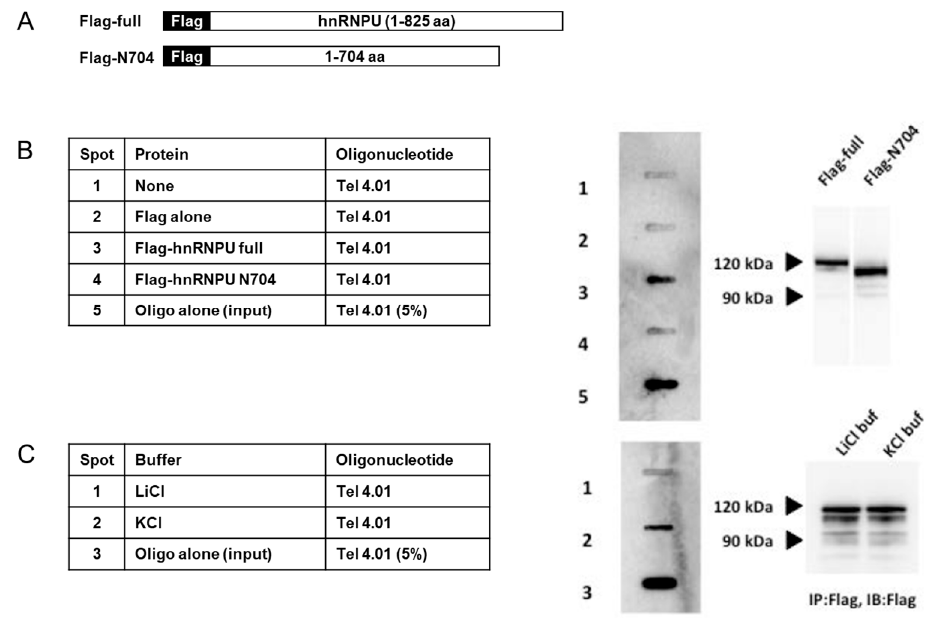
Figure 1. ( A ) Schematic illustration showing full length and N704 (expressed 1-704 aa) of Flag- heterogenous ribonucleoprotein U (hnRNP U) protein. ( B ) Flag-hnRNP U full length and N704 fusion proteins expressed by COS1 cells were immunoprecipitated (IP:d) with anti-Flag agarose gel and were mixed with Tel oligonucleotides in KCl buffer. After washing the beads, bound oligonucleotides were transferred to the membrane and detected by electrochemical luminescence (ECL). ( C ) Flag-hnRNP U FL-fusion proteins extracted from COS1 cells were IP:d with anti-Flag agarose gel. IP were mixed with Tel in KCl buffer or LiCl buffer. Same treatment as in Figure 1A. Oligo alone (input) indicates that the 5% oligo used in the binding assay was spotted directly.